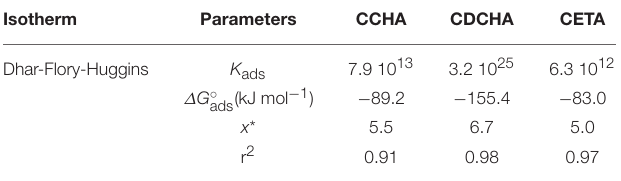
TABLE 3 | Parameters obtained from the Dhar-Flory-Huggins adsorption isotherm. Isotherm